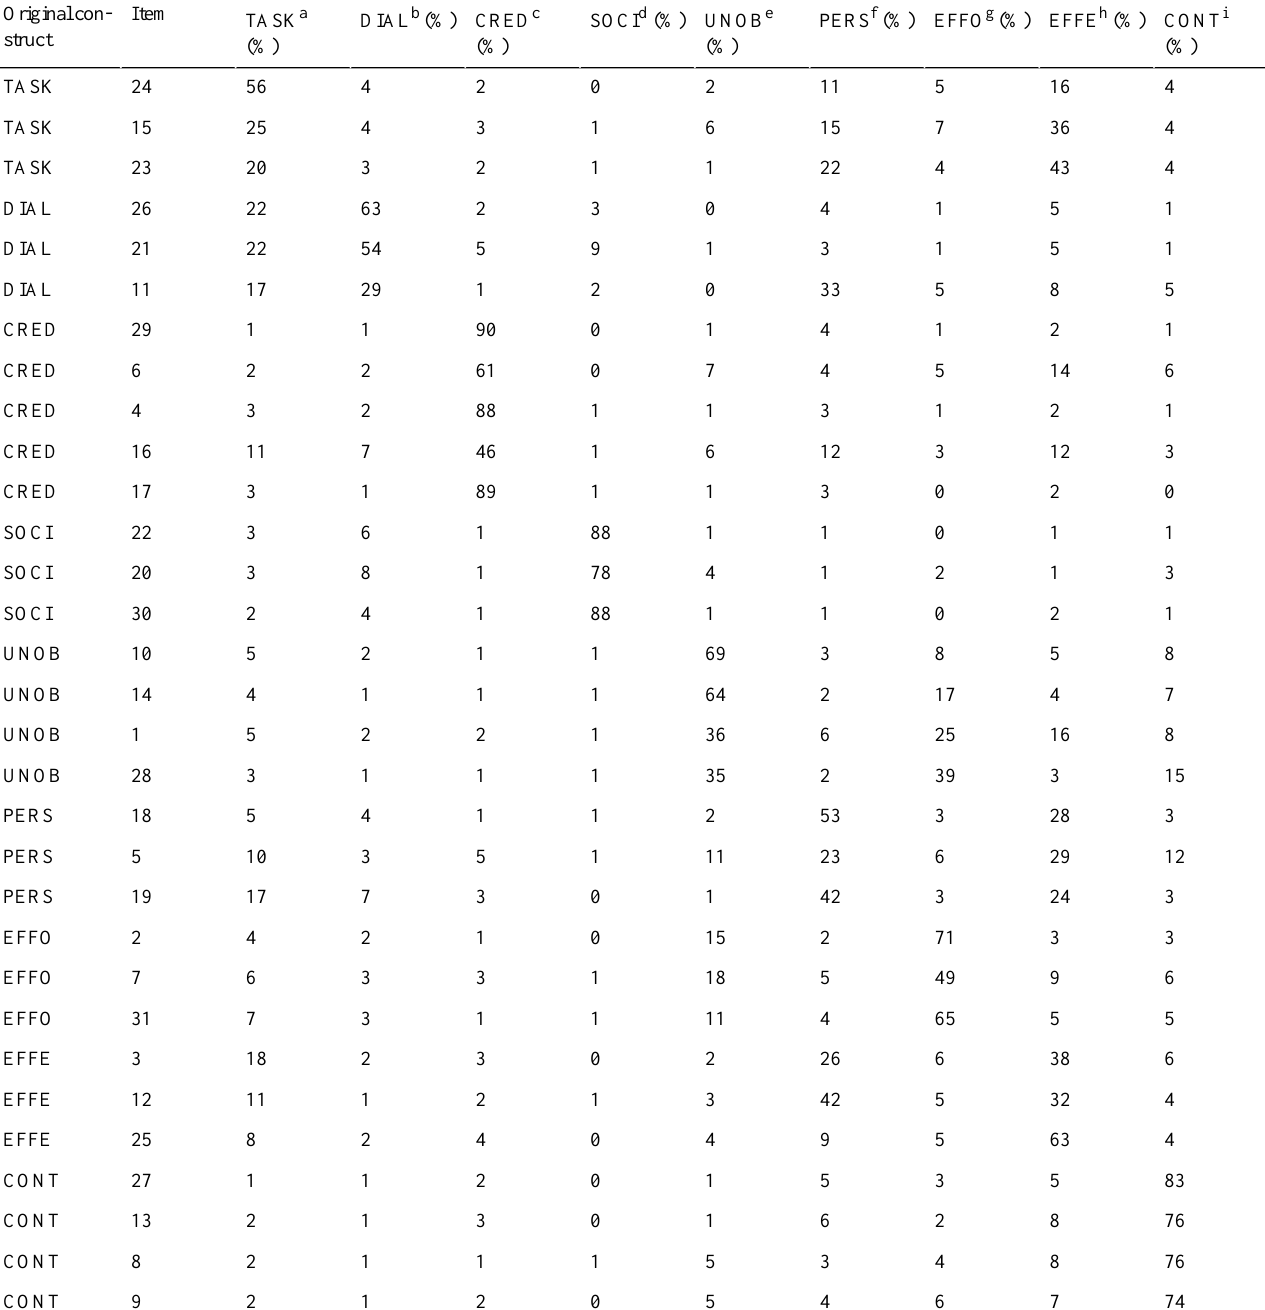
Table 3. Item-level agreement in original Perceived Persuasiveness Questionnaire